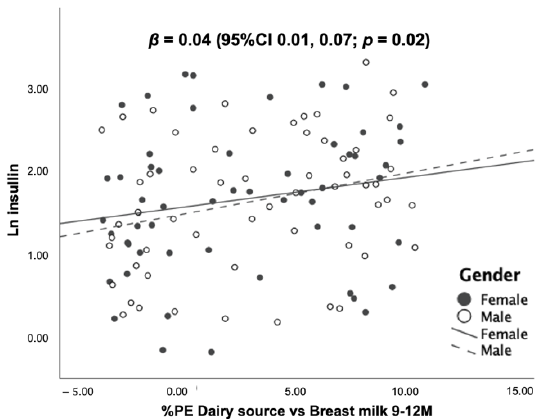
Figure 5. Scatter plots and regression statistics of blood levels of IGF-1, IGFBP-3 and insulin at 12 months of age by %PE from dairy vs. breast milk at 9–12 months (stratified by sex). Scatter plots illustrate the associations between the percentage of protein energy from dairy sources ( i.e., formula and cow’s milk ) subtracted from the percentage of protein en- ergy from breast milk (%PE dairy source vs. breast milk) and blood concentrations of IGF- 1, IGFBP-3 and insulin at 12 months. The scatter plots show dose – response, positive asso- ciations between %PE dairy source vs. breast milk, and all laboratory markers after con- trolling of sex.